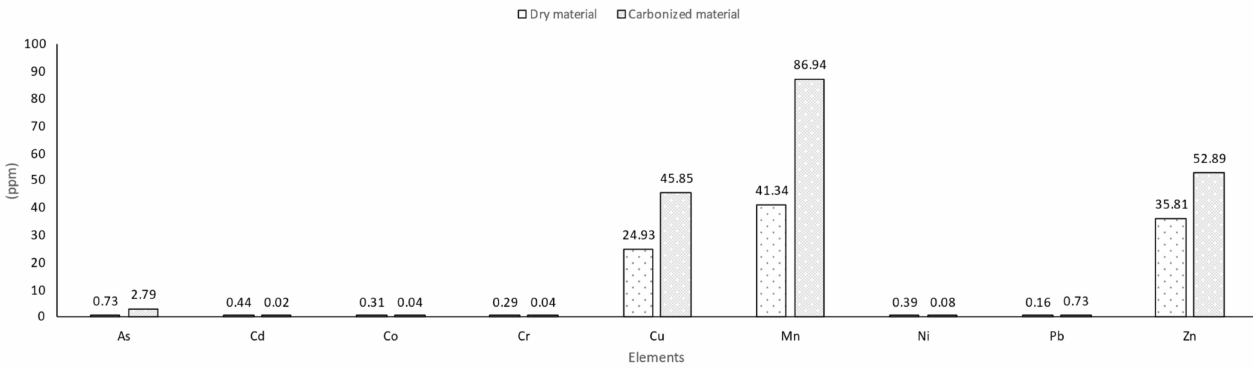
Figure 9. Evolution of minor elements content after carbonization of vine